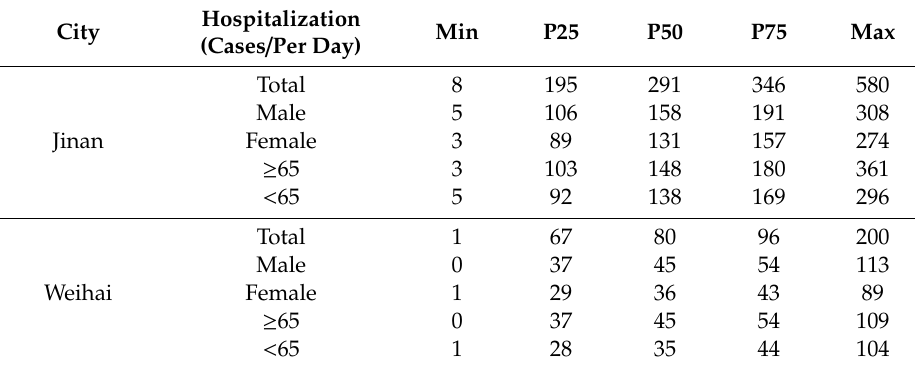
Table 1. The daily hospital admissions grouped by sex, age, and sub-disease in the cities of Jinan and Weihai (from 1st January, 2014 to 31st December, 2016). Hospitalization City (Cases / Per